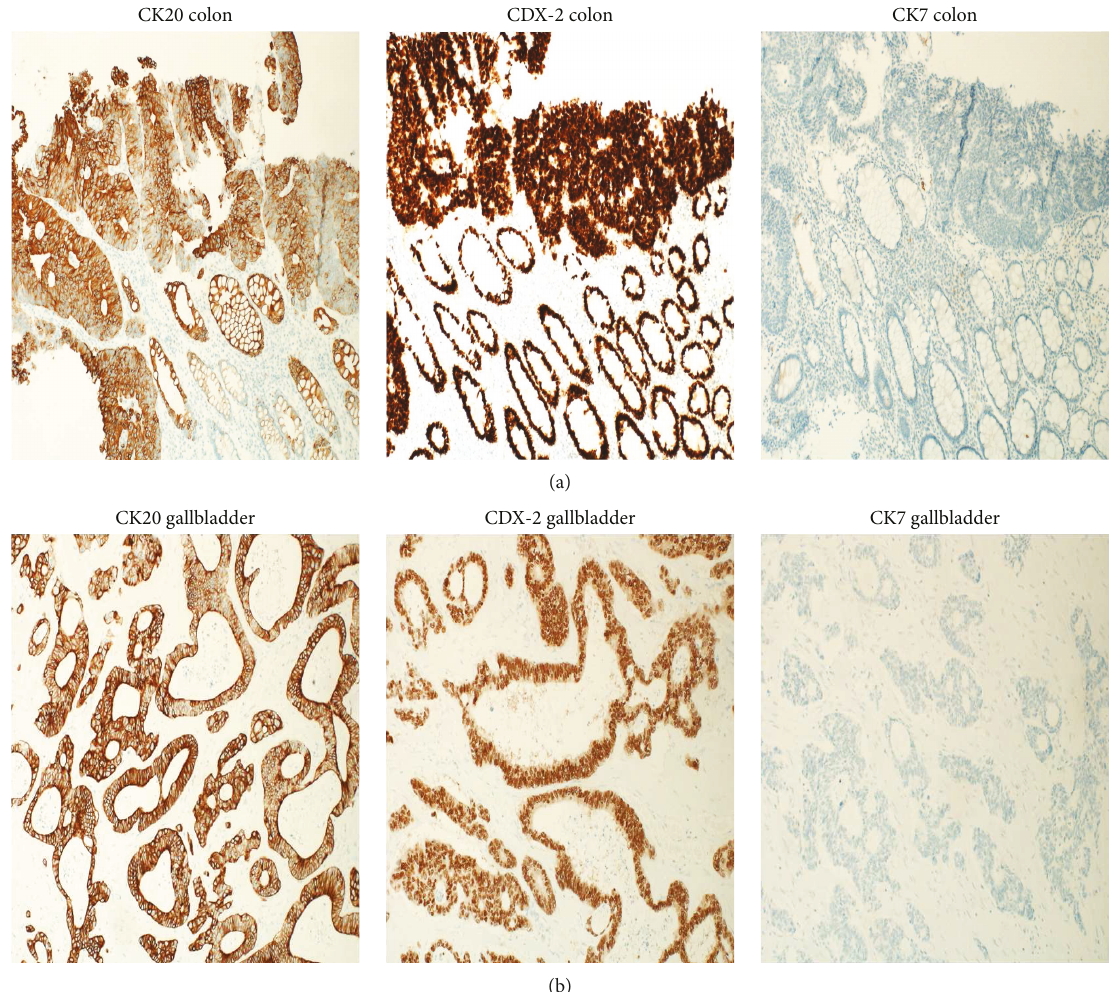
Figure 2: (a) Immunohistochemical analysis on the colon specimen. The specimen is CK20 positive, CK7 negative, and CDX-2 positive. (b) Final immunohistochemical analysis on the gallbladder specimen. The specimen is clearly CK20 positive, CK7 negative, and CDX-2